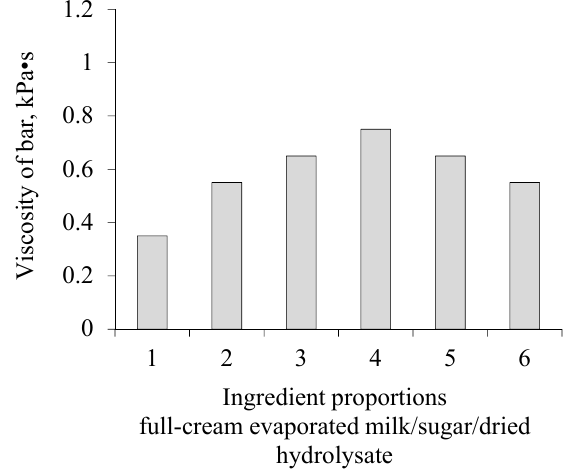
Fig. 9. Dependence of bar viscosity on ingredient proportion at 90°C (1 – 100 : 43 : 2; 2 – 105 : 38 : 2;